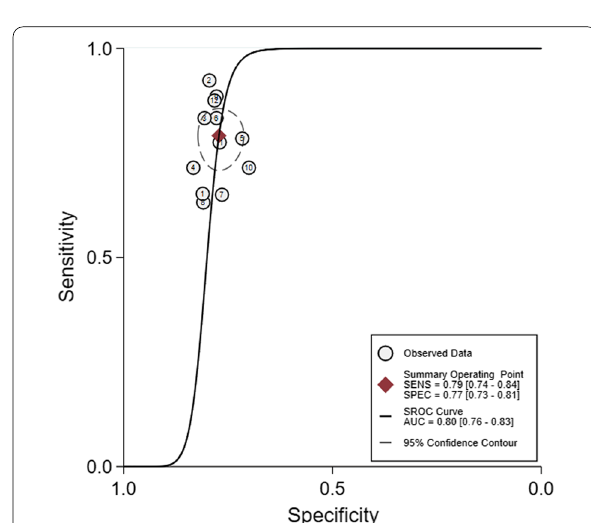
Fig. 4 Summary receiver operating characteristics (SROC) curve regarding the diagnostic performance of machine learning in predicting axillary lymph node metastasis in breast cancer patients. SROC curve (solid line) and summary point (red square). Every circle represents the sensitivity and specificity estimate from one study, and the size of the circle reflects the sample size. The pooled area under the curve was